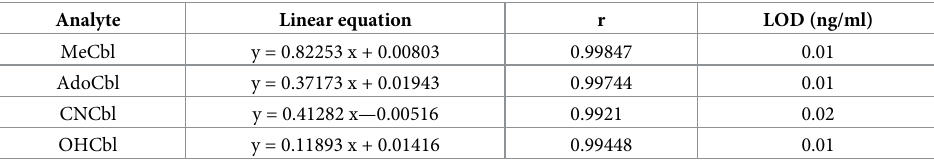
Table 3. Linear equation, correlation coefficient (r) and LOD of the four